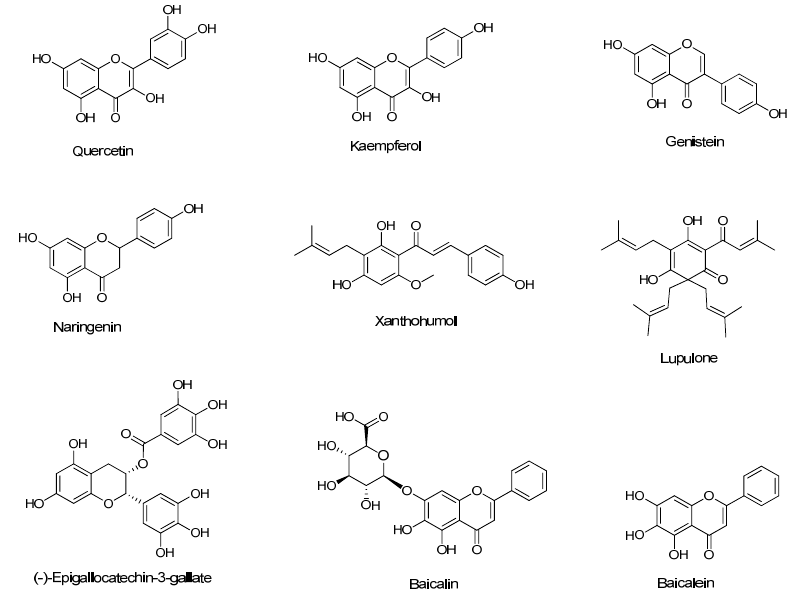
Figure 5. Chemical structures of selected flavonoids mentioned throughout this review.